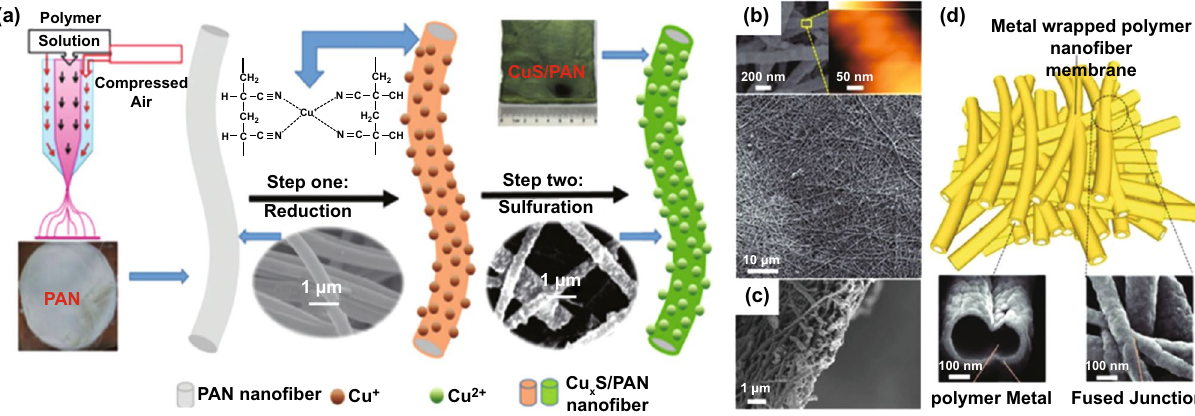
Fig. 12 a Schematic diagram for the preparation of Cu x S/PAN nanofiber mat [131]. Copyright © 2019 WILEY ‐ VCH Verlag GmbH & Co. KGaA, Weinheim; b-d SEM and AFM (the scale bar for height is 0–240 nm) images of the Cu-wrapped nanofibers in the cellular membranes; cross-sectional SEM image of the membranes; Schematic and microstructure of the cellular membranes composed of high-conjunction Cu- wrapped polymer (PDA precoated nylon) nanofibers [132]. Copyright © 2020 WILEY ‐ VCH Verlag GmbH & Co. KGaA,